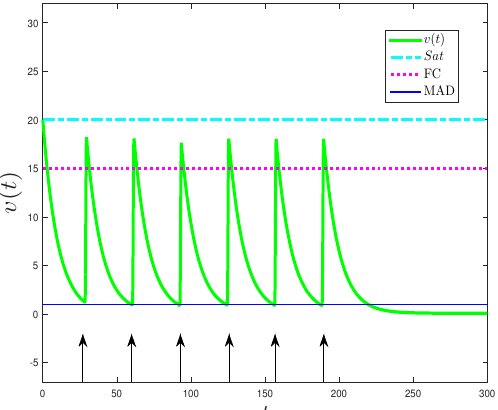
Figure 4. Soil water content v ( t ) for the plants’ growth. The horizontal lines represent the soil water thresholds, Saturated soils (Sat, upper line), Field Capacity (FC), and Management Allowed Depletion (MAD, bottom line). The vertical arrows indicate the times when irrigation is applied. Initial conditions x ( 0 ) = 3.0, ω ( 0 ) = 7.0, v ( 0 ) = 20.0, parameter values κ = 0.01, g = 0.1, m = 0.00001, δ = 1.0, r = 20, β = 0.1, k = 0.01, γ = 0.000009, ρ = 2.0.